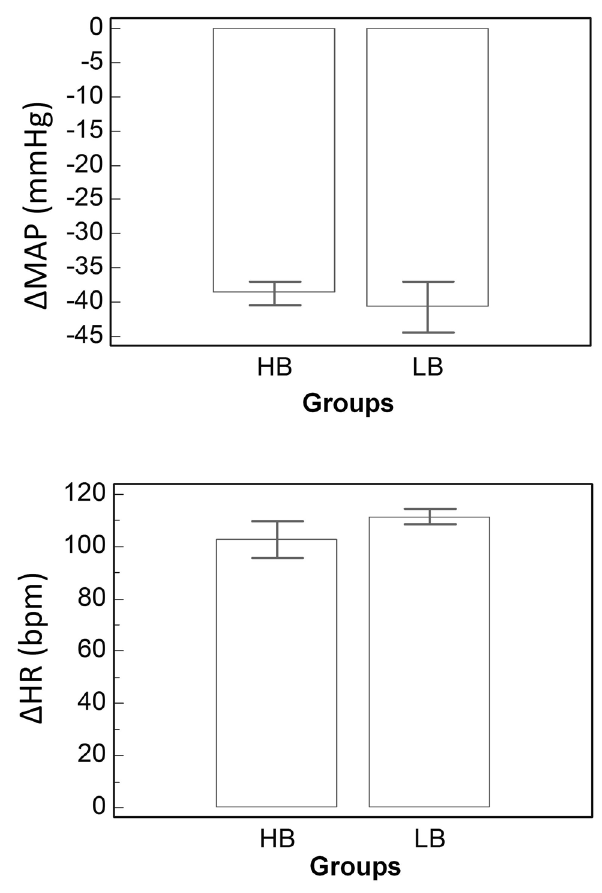
Figure 2 - Decrease in mean arterial pressure (MAP, mmHg) and decrease in heart rate (HR, bpm) in response to sodium nitroprusside (SNP, 50 m g/kg i.v.) in HB (n=14) and LB (n=8) groups.